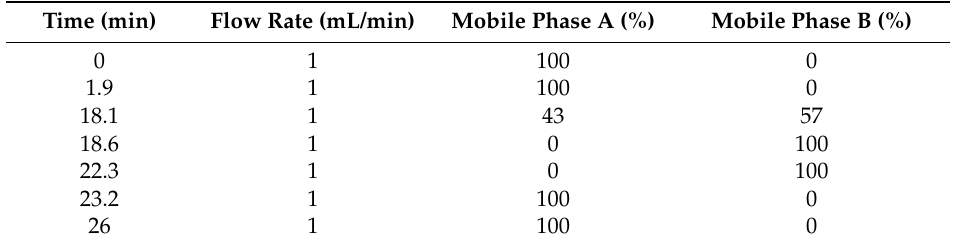
Table 3. The mobile phase gradient for on-line pre-column derivazation RP-HPLC analysis of amino acid composition.